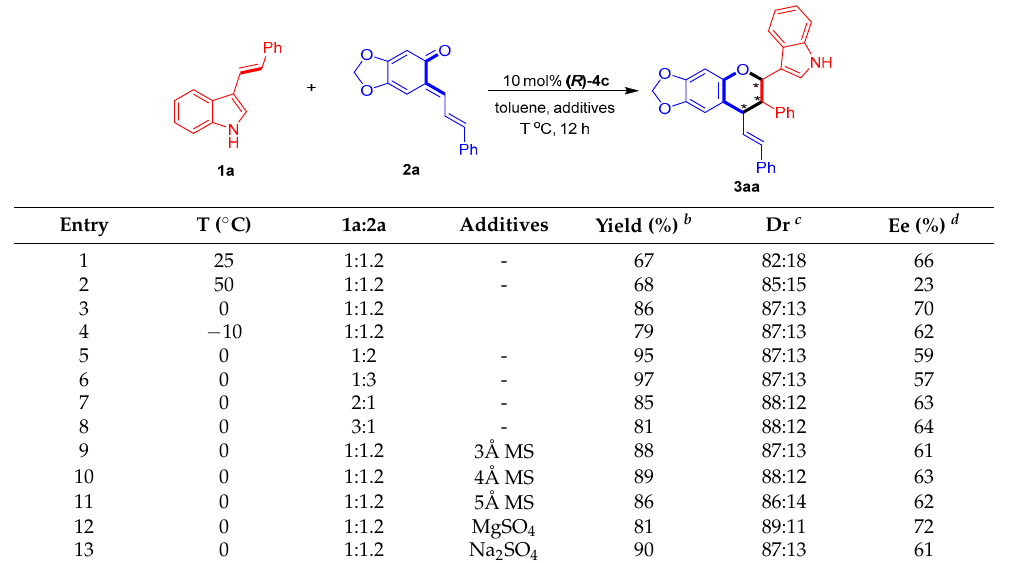
Table 2. Further optimization of reaction conditions a .